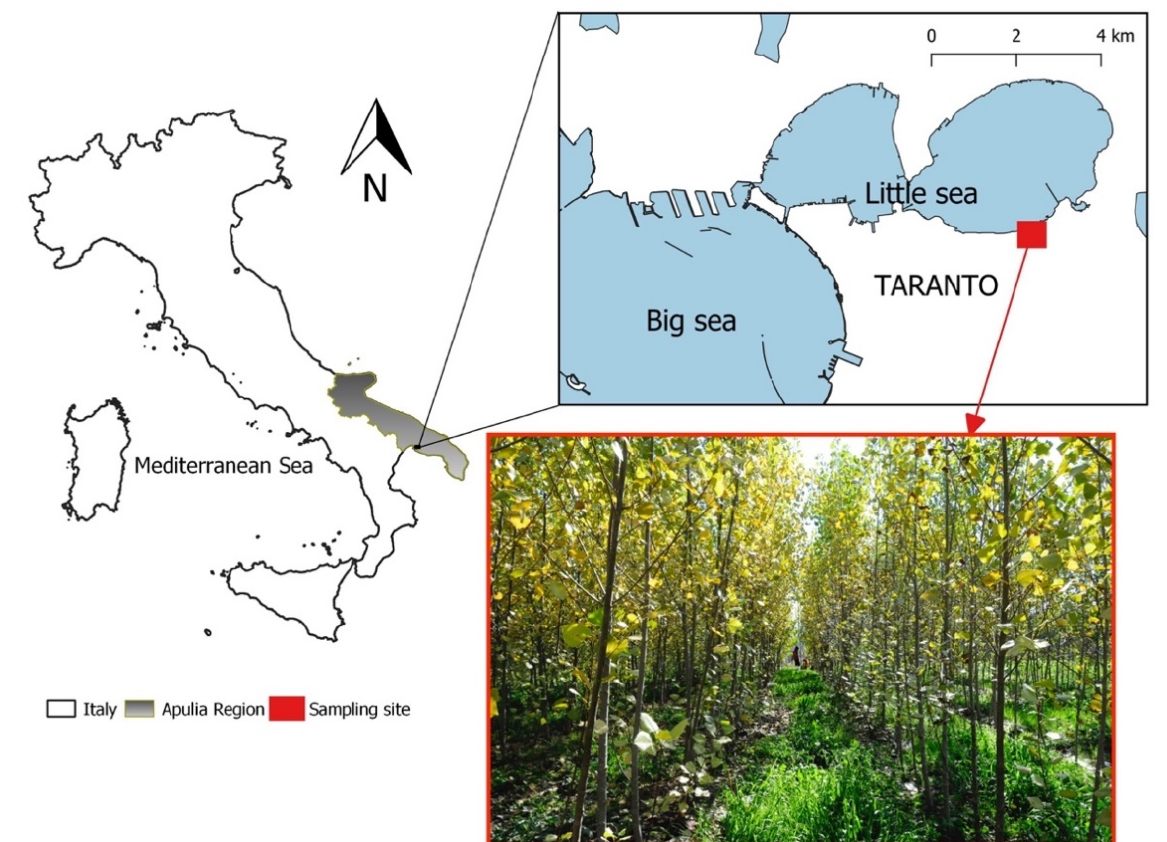
Figure 1. Map of the experimental area planted with poplars.